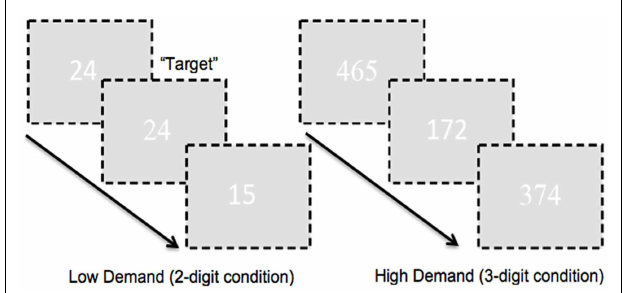
FIGURE 1 |A schematic of the employed CPT-IP task is shown .The task alternated between two- and three-digit extended epochs and subjects were required to detect repeated presentation of numbers. As seen attention demand was modulated by manipulating figure-ground contrast.